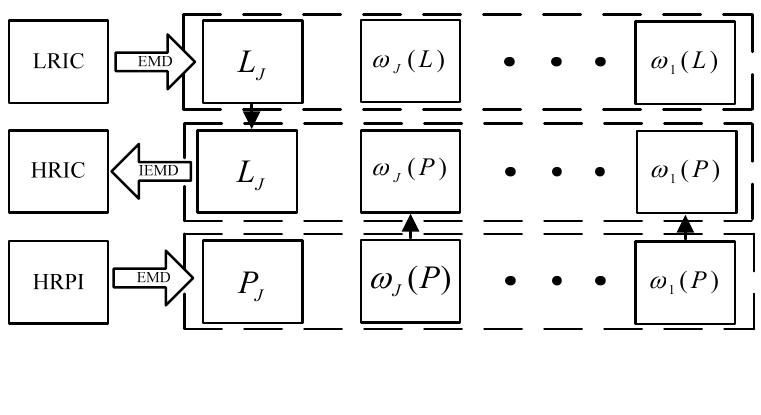
Figure 3. Schematic flowchart of the fusion of the LRIC and the